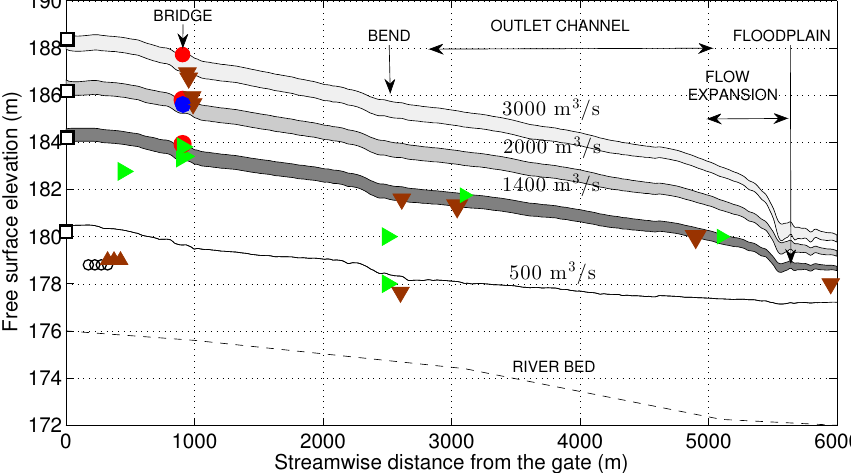
Figure 6. Streamwise profile of the simulated water surfaces for the flow discharges: 500 ( n = 0.02 s · m − 1/3 ), 1400 (0.04 ≤ n ≤ 0.05 s · m − 1/3 ), 2000 and 3000 m 3 · s − 1 (0.05 ≤ n ≤ 0.06 s · m − 1/3 ). The dotted line represents the thalweg profile. Symbols correspond with the PSIs in Figures 2b and 3a, except empty circles and upward triangles which represent pebbles and dunes,